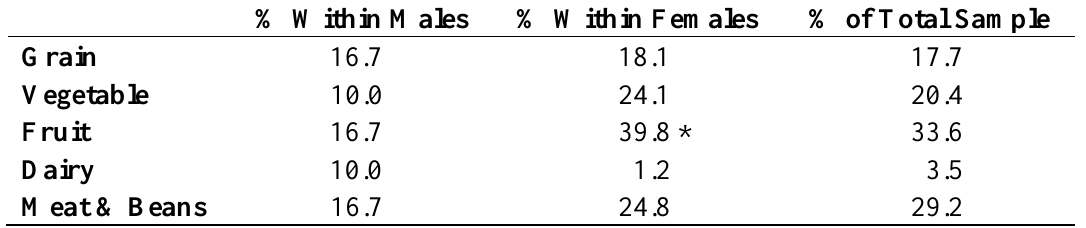
Table 2. Percent of participants achieving adequate intakes of each of the five food